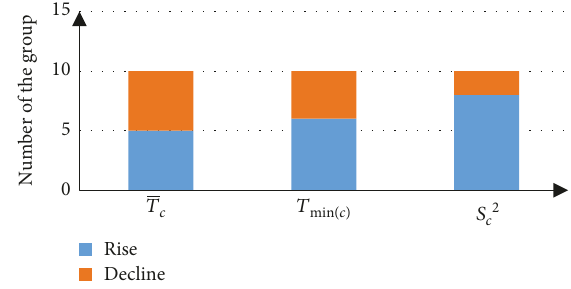
Figure 5: Feature parameters ’ variation in the insu ffi cient fi lling